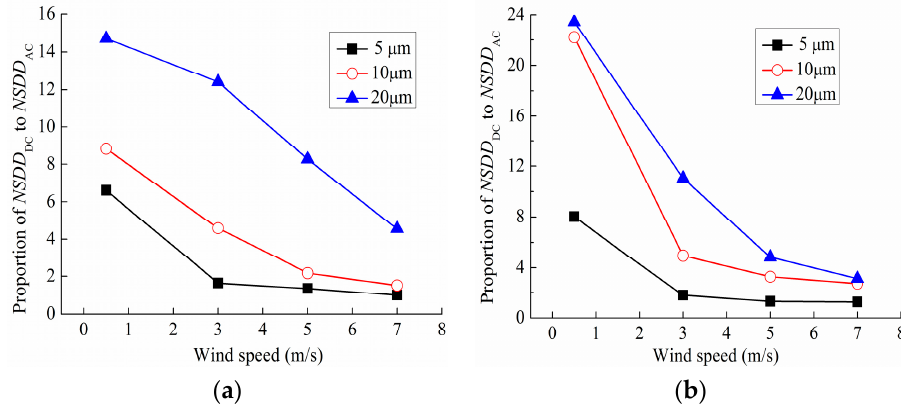
Figure 8. Proportion of NSDD DC to NSDD AC versus wind speed curves, ( a ) porcelain three-umbrella insulator; and ( b ) porcelain bell jar insulator.